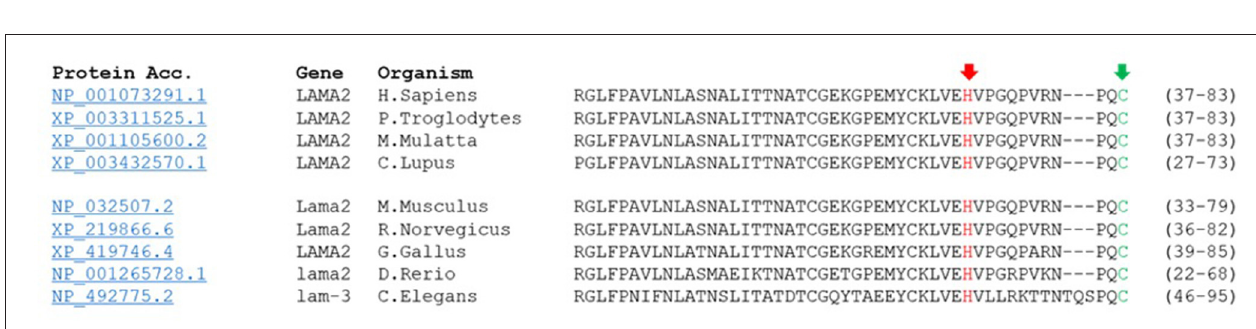
FIGURE 6 | His72 is conserved in laminin α 2-protein sequence. His72 is switched through missense variant c.215A > C to proline. Alignment of laminin α 2 peptide sequences from human, chimpanzee, rhesus monkey, wolf, mouse, rat, chicken and fish and their homolog in C. elegans shows phylogenetic conversation of His72 at this position (red arrow). Moreover, peptide sequence reveals close proximity of the peptide switch to Cys79 (CxxC motif, green